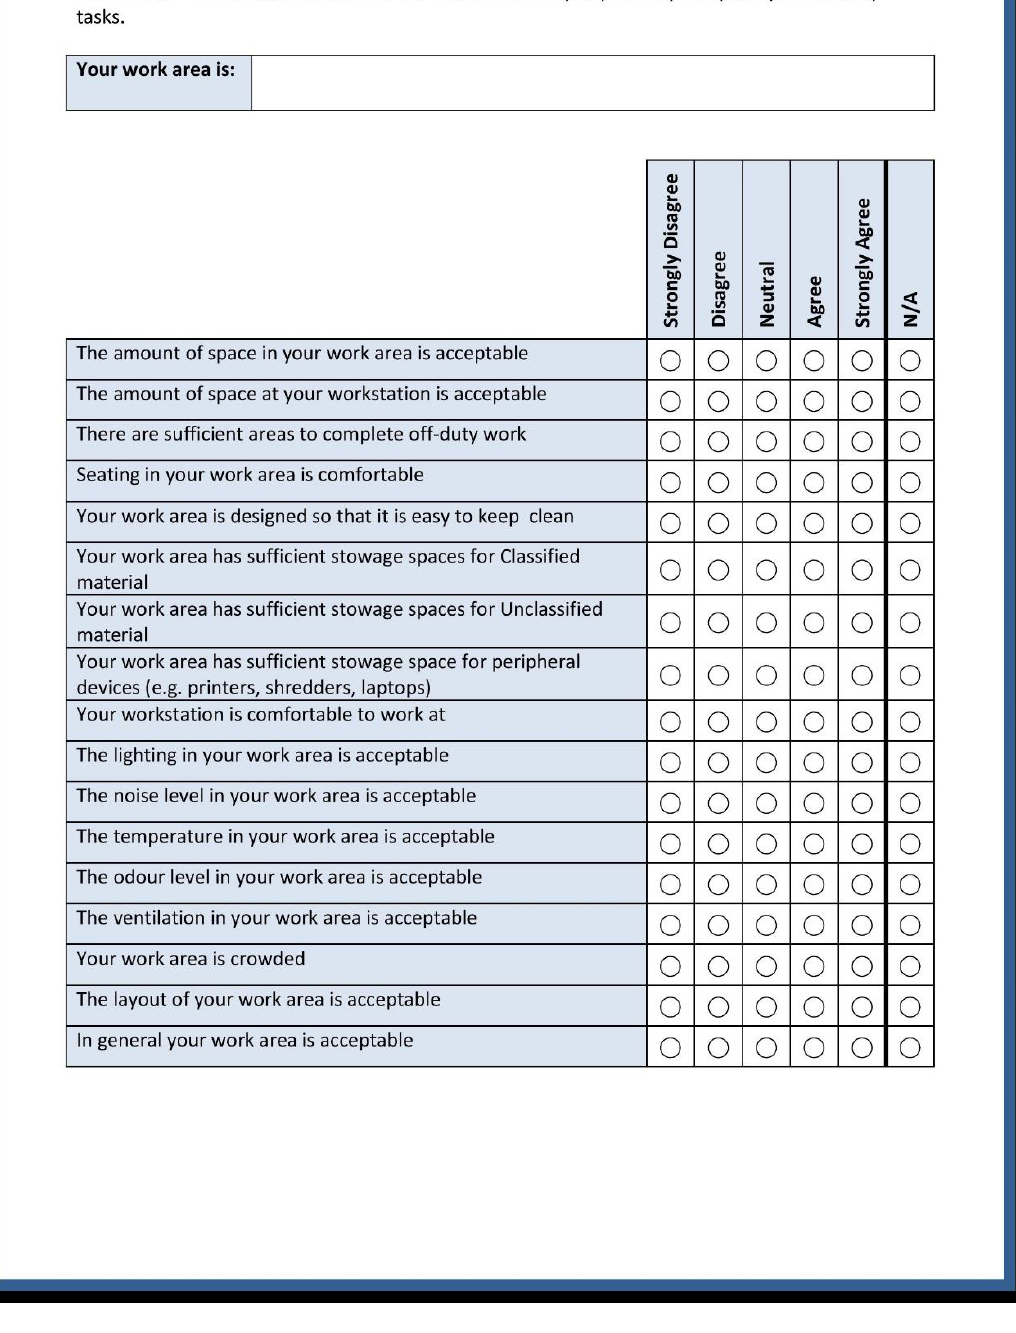
Figure A4. The Submarine Habitability Assessment Questionnaire (continued).